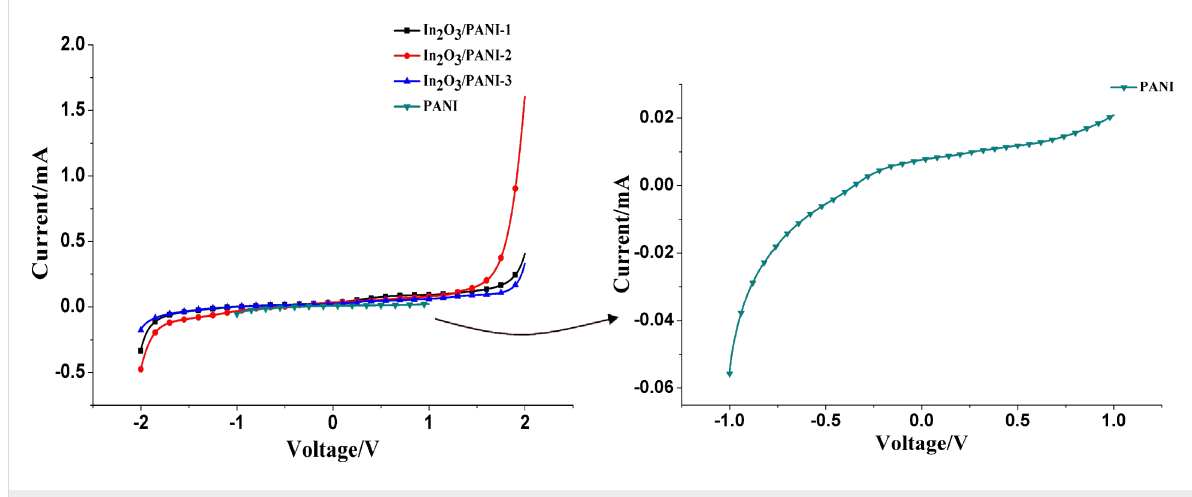
Figure 4: Current–Voltage ( I – V ) characteristics of pure PANI and In 2 O 3 /PANI nanofibers.